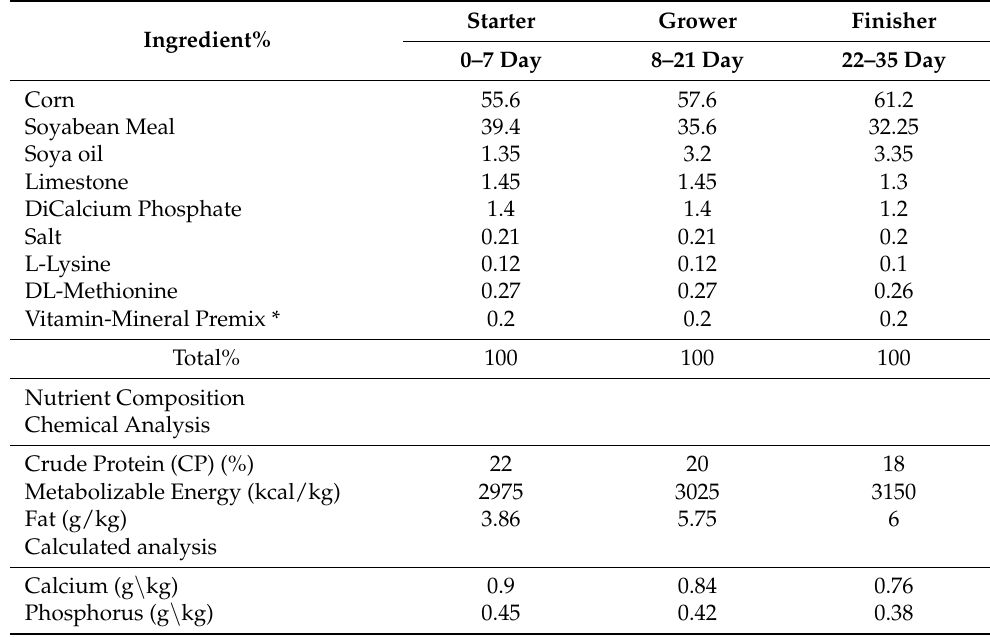
Table 1. Formulation and chemical analyses of the basal broiler diets.